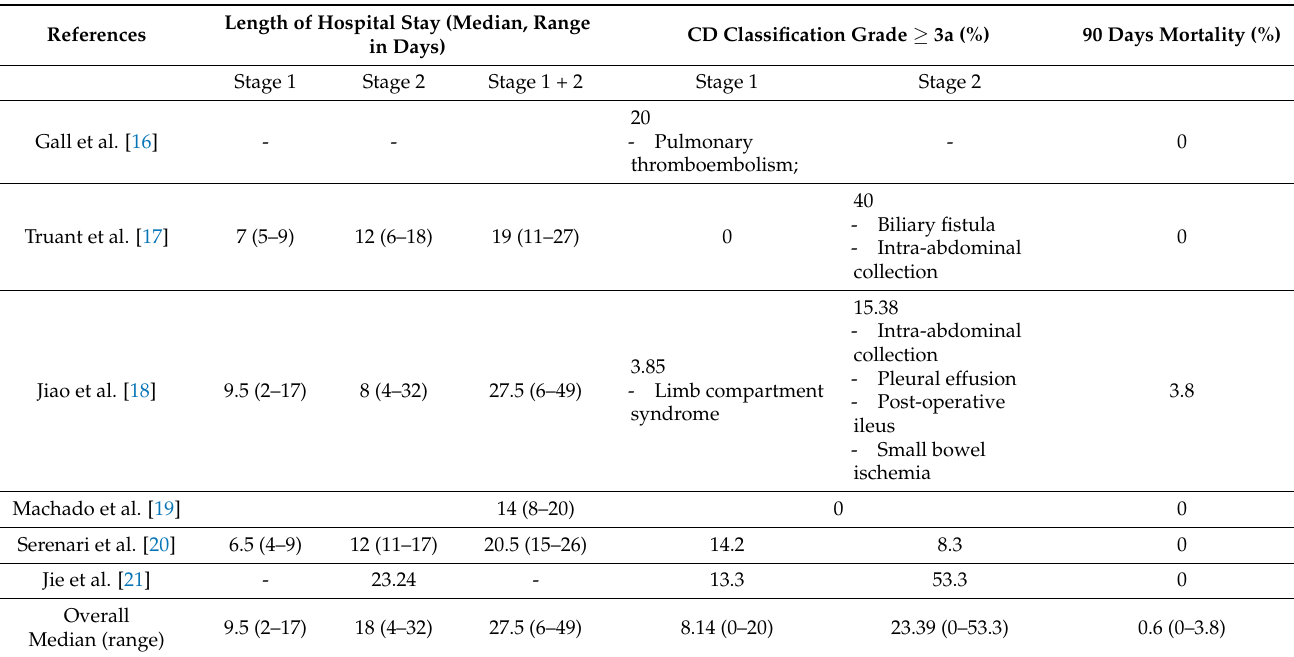
Table 4. Post-operative data MI-ALPPS.